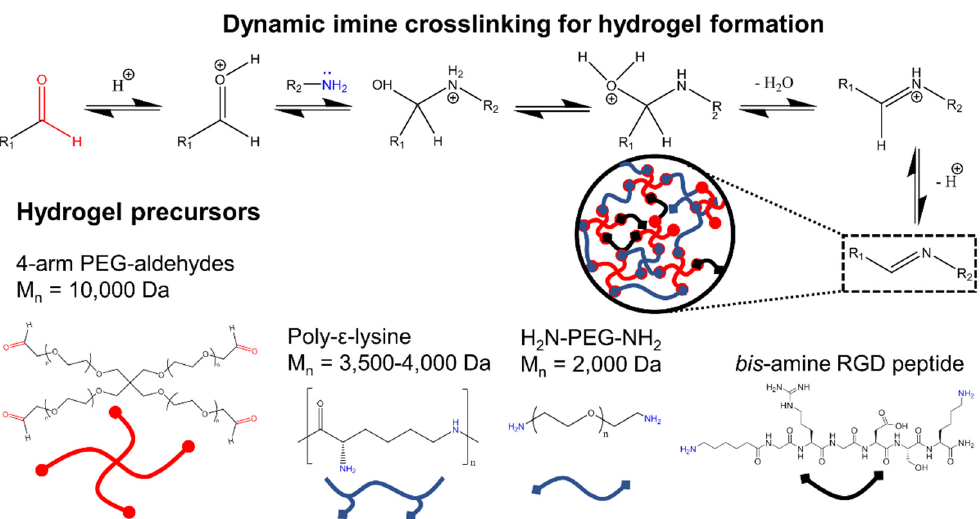
Figure 1. Hydrogels generated via dynamic imine crosslinking. The hydrogels were fabricated using a 4-arm PEG each terminating in an aldehyde group and mixed with either poly- ε -lysine to give HG-P ε K or a linear diamine PEG to give HG-PEG. The peptide arginine-glycine-aspartic acid (RGD) was synthesized as a bis -amine and was added at differing concentrations to promote cell binding.